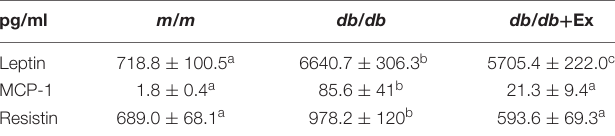
TABLE 2 | Serum adipokines and chemokine.